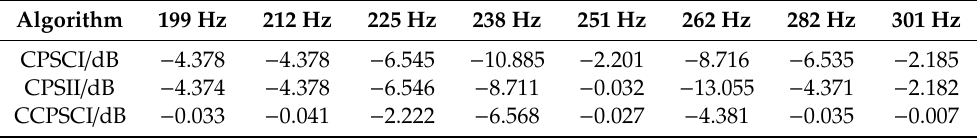
Table 3. Averages of discrete spectra in experimental data